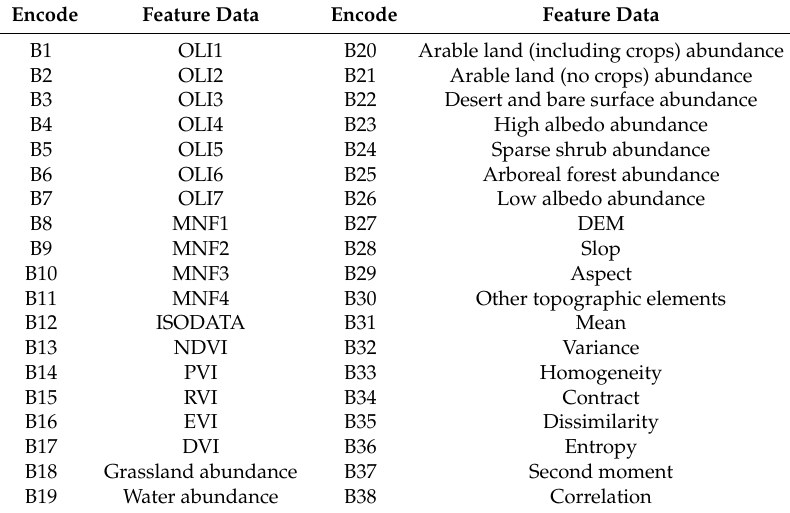
Table 3. Feature dataset of improved decision